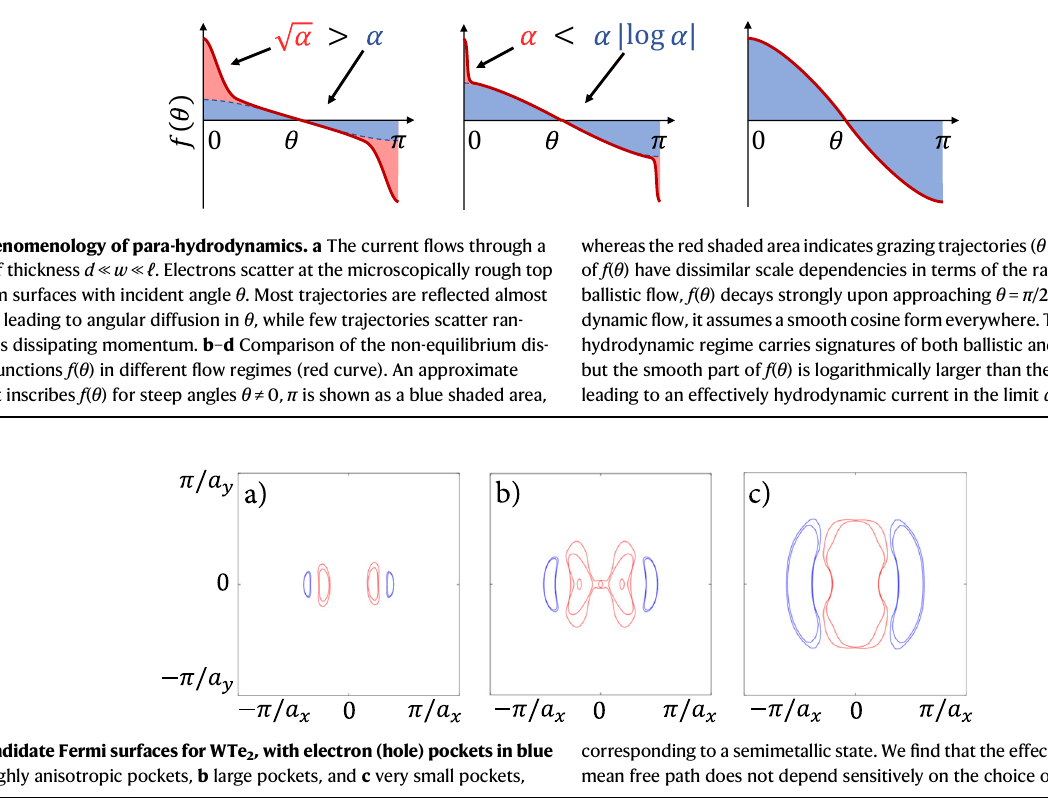
corresponding toa semimetallicstate.We fi nd thatthe effectiveelectron – electron mean free path does not depend sensitively on the choice of Fermi